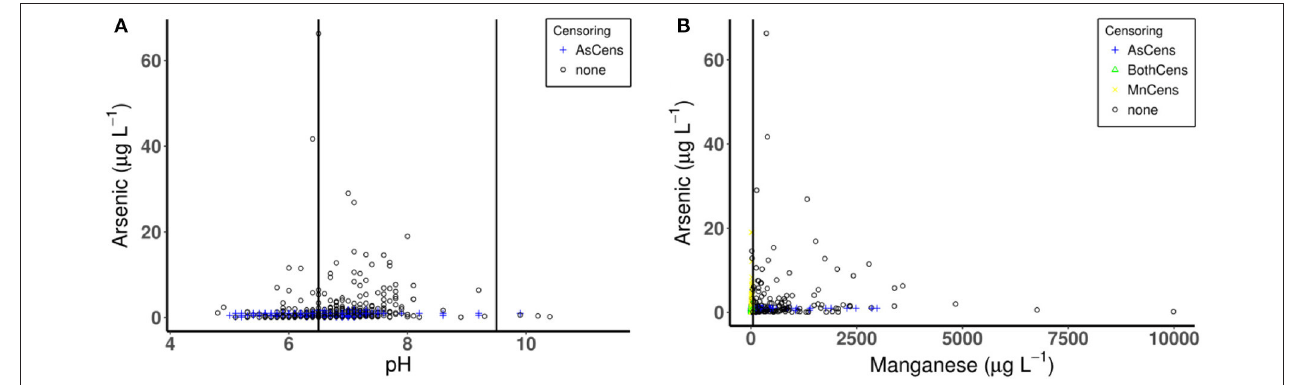
FIGURE 6 | Correlation plot of arsenic (A) and pH (6.5, 9.5) and (B) Mn (50 µ g L − 1 ). Values in parenthesis are water quality standard values. Where AsCens is censored values for arsenic, BothCens are both values censored and none indicates no censoring.